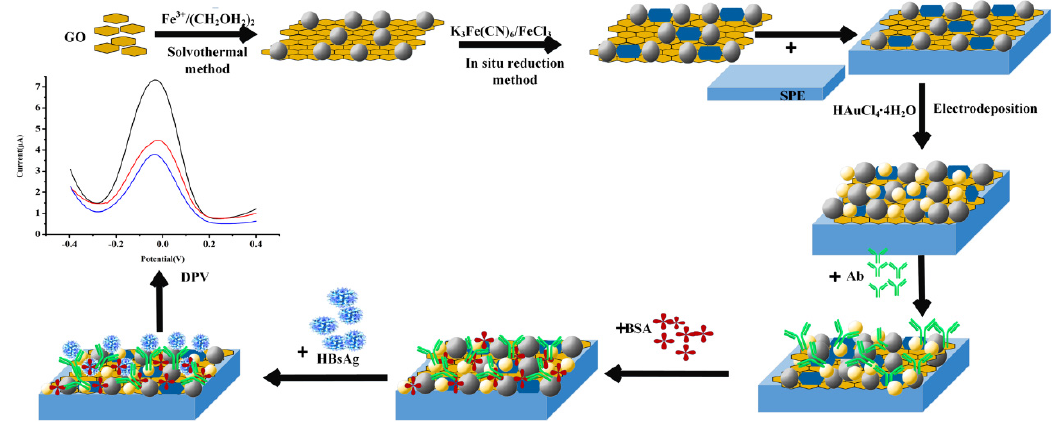
Figure 1. The schematic illustration for fabrication of the electrochemical immunosensor.